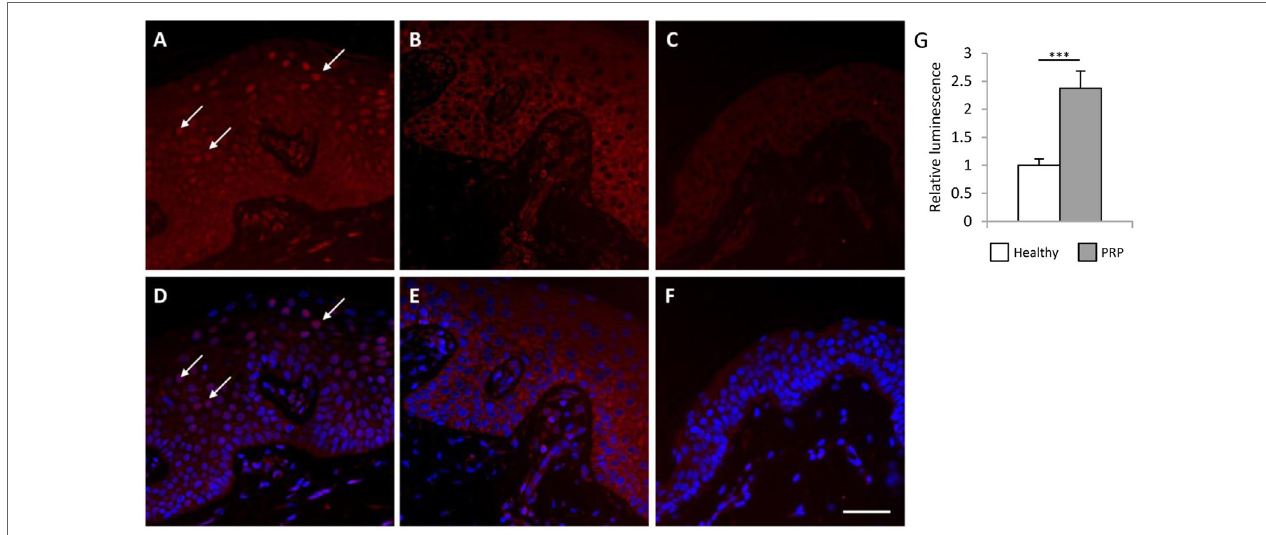
FIgURe 2 | Lesional Pityriasis rubra pilaris (PRP) skin samples and keratinocytes exhibit higher nuclear factor κ B (NF κ B) activation compared to healthy samples. Skin­biopsy sections obtained from the PRP patient [lesional area: (a,D) non­lesional area (B,e) ] and from a healthy individual (C,F) were stained with antibodies against the p65 subunit of NF κ B. Nucleic staining of p65 comprises of active NF κ B. Arrows indicate the p65­positive nuclei in the lesional PRP samples (a–D) , while no nuclear p65 staining was observed in the healthy and non­lesional PRP skin (Bar = 100 μ m, healthy samples are representative for two individuals). Higher basal NF κ B activity was observed in the cultured PRP keratinocytes compared to healthy keratinocytes by NF κ B­luciferase reporter assay (g) . Cells were co­transfected with the pNF κ B­luc Cis­Reporter Plasmid and the pGL4.75 control plasmid [hRluc/CMV]. The luciferase activity derived from the NF κ B­luc plasmid was normalized to the activity of Renilla luciferase activity from the pGL4.75 [hRluc/CMV] plasmid, and compared to the luciferase activity of the healthy samples. Data are represented as mean ± SE, significance was determined by Student’s t ­test; *** p <